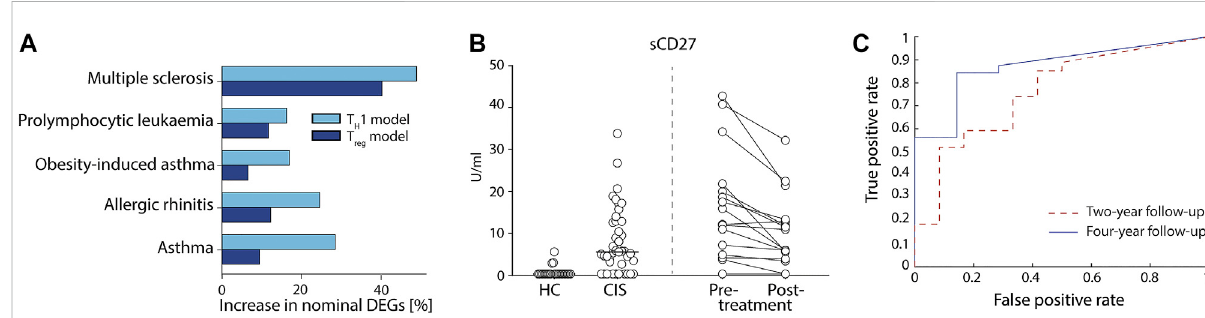
Proteins models led to the discovery of new potential biomarkers of complex diseases that were validated in multiple sclerosis (MS). (A) Differential predicted protein (PP) analysis of fi ve diseases using the T H 1 (light blue) and T reg (dark blue) models showed higher fraction of nominally signi fi cant genesthanthat ofnormaldifferentialgeneexpression tests. (B) Measurementofactualproteinlevels ofthepredictedproteinsinacohort ofpatientswithearlyMS[clinicallyisolatedsyndrome(CIS)]vs.healthycontrols(HC)(leftsideofthe fi gure)andfromacohortofMSpatientspre vs. post 1-year treatment with Natalizumab (right side of the fi gure). sCD27 was measured in cerebrospinal fl uid (CSF) using ELISA. (C) Receiver operating curve using sCD27 concentration as a single prognostic marker of NEDA at four (solid line) and 2 years (dashed line) after